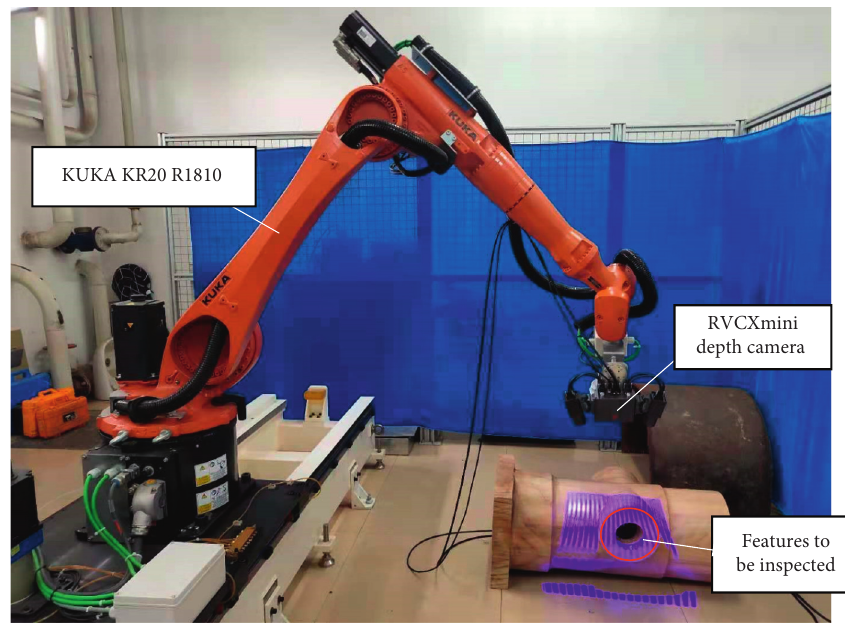
Figure 14: Visual inspection and identification of features.